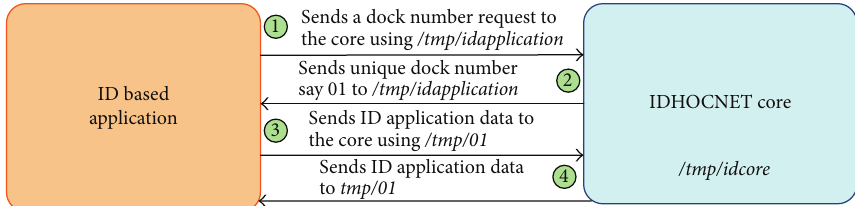
Figure 13: Identifier based application